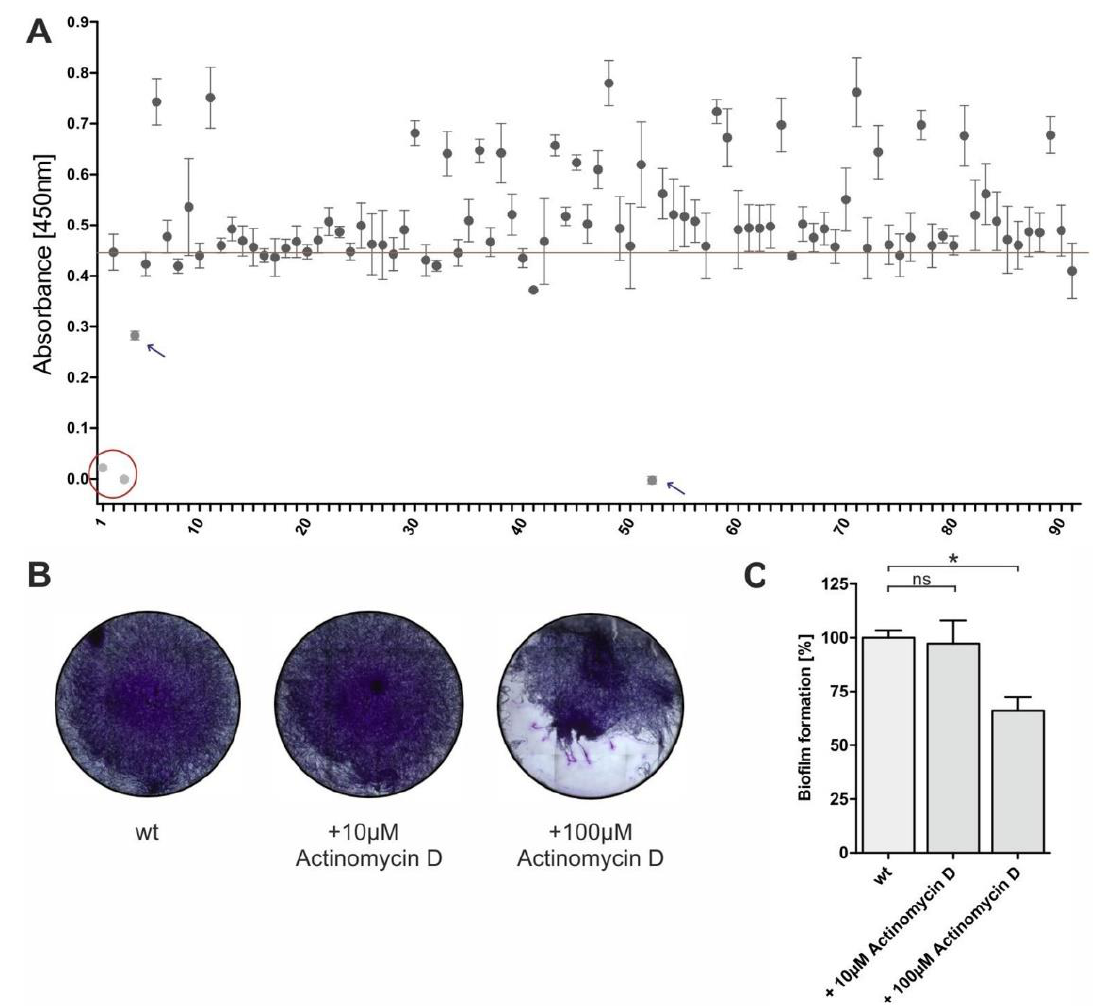
Figure 2. Effect of microbial natural compounds on Agd3 enzymatic activity. ( A ) Microbial natural compounds from bacteria and fungi were screened for their ability to inhibit Agd3 activity in a GAG ELLA assay. Results from a plate containing 88 compounds are displayed. The red line indicates 100% activity determined by measuring the Agd3 activity in absence of additional compound. Samples without Agd3 enzyme (position 1, circled in red) or with Agd3 incubated with 5 mM dipicolinic acid (position 2, circled in red) were used as negative controls. Compounds 4 and 52 marked with a blue arrow inhibited Agd3 activity (n = 3). ( B ) Actinomycin D (Compound 52 ) showed the inhibition of the biofilm formation in a crystal violet staining. ( C ) Quantification of the biofilm stain via absorbance measurement (n = 3). Statistical analysis was run by one-way repeated measures ANOVA and Bonferroni’s multiple comparison test. * ( p < 0.05): ns: